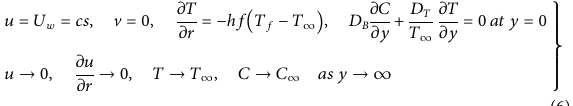
FIGURE 18 Disparity of Nb on ϕ .